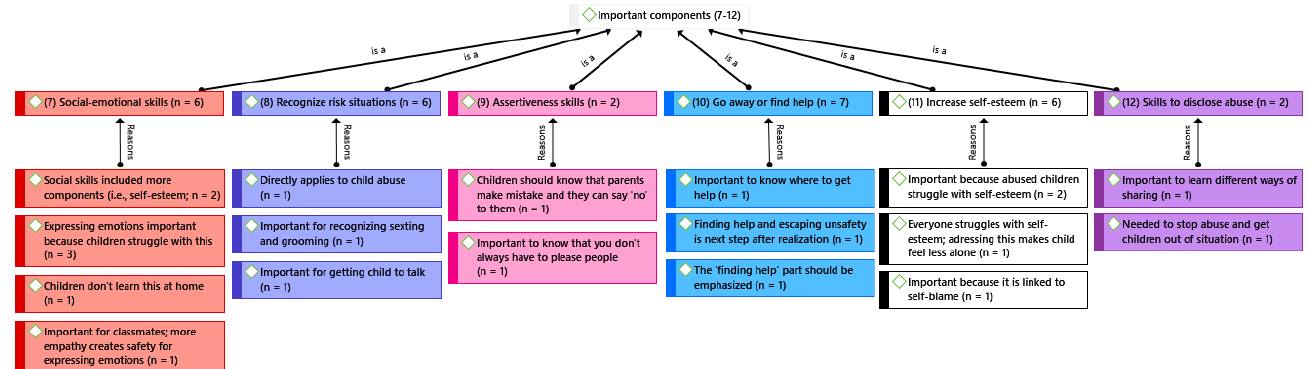
Figure 2. An overview of the results as related to the second set of six components. The labels on the second level refer to the components and the labels on the third level refer to the reasons as provided by the participants for the importance of each component. Red labels refer to the components (7) increasing social–emotional skills, dark blue labels to (8) recognizing and avoiding risky situations, pink labels to (9) increasing assertiveness skills, light blue labels to (10) learning to go away from a potential abusive situation or to find help, white labels to (11) increasing a child’s self-esteem, and purple labels to (12) learning skills to disclose abuse. n = the number of participants.